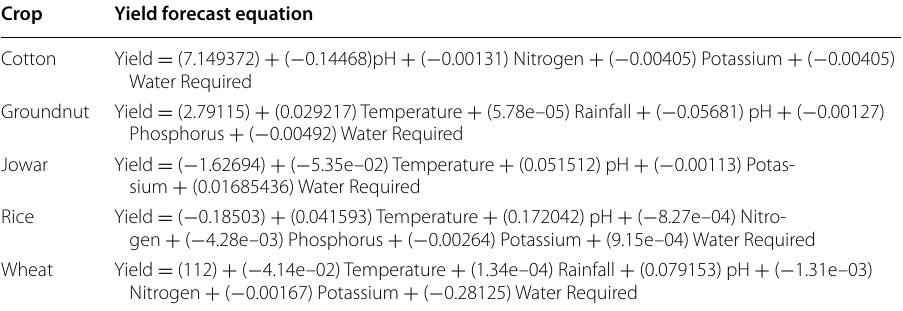
Table 4 Multiple linear regression equation for different crop yield Crop Yield forecast